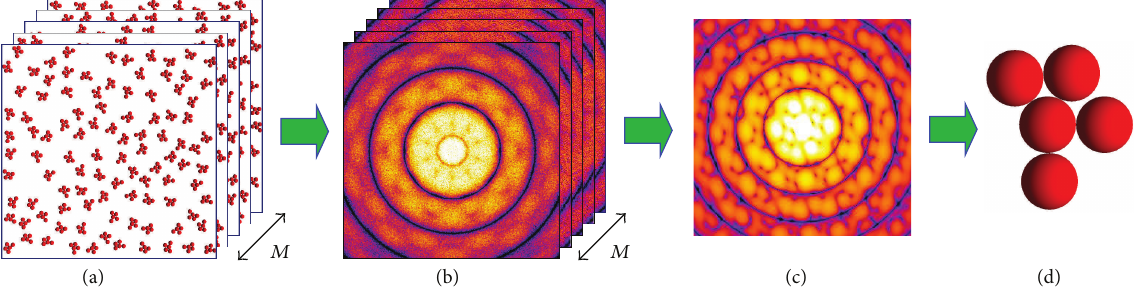
Figure 2: A concept of recovery of the structure of a single particle using X-ray scattering data from many particles. A large number 𝑀 of realizations of a disordered system (a) composed of many identical particles is used to collect 𝑀 diffraction patterns (b). X-ray cross- correlation analysis is applied to this X-ray data set to recover a diffraction pattern (c) corresponding to a single particle. The structure of a single particle (d) is determined applying phase retrieval algorithms to the recovered diffraction pattern